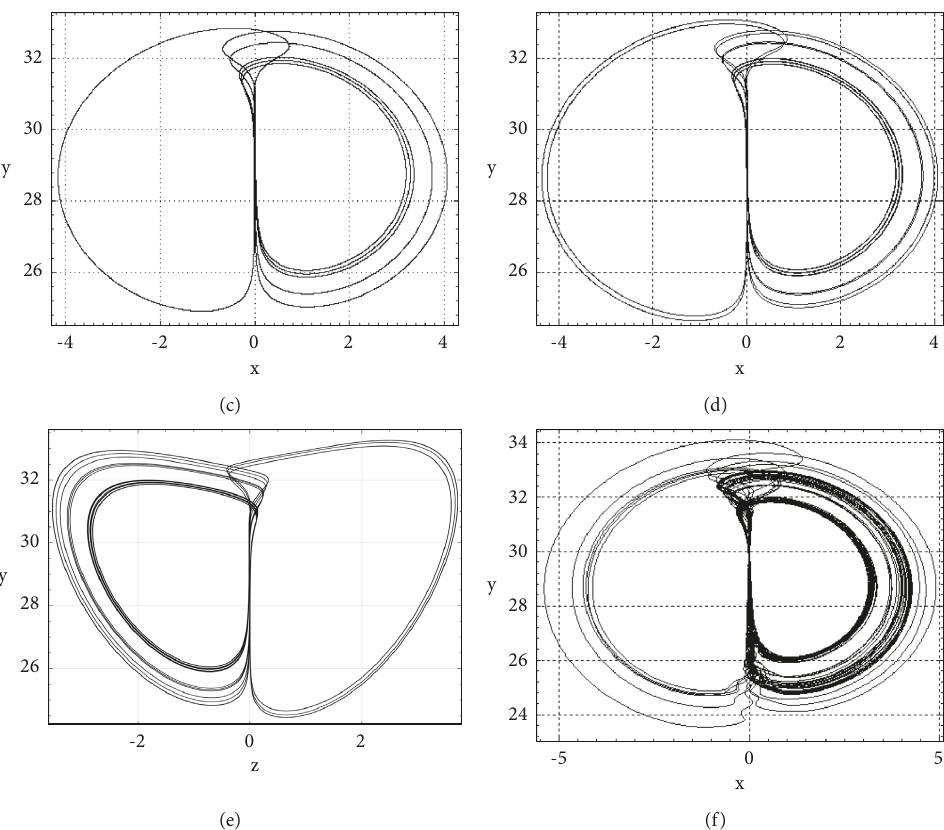
Figure 14: Phase portraits plotted showing the sensitivity of the system towards squared amplitude of the load torque: F � 1 Hz; x 0 � 0.01; y 0 � 0.01; z 0 � 20; h:0.005; c � 30; u � 0.009; v � 0.005; beta � 0.03; σ � 3.105; (a) T 3 �− 0.02, (b) T 3 �− 0.012, (c) T 3 � 0.001, (d) T 3 � 0.05, (e) T 3 � 0.05, and (f) T 3 �